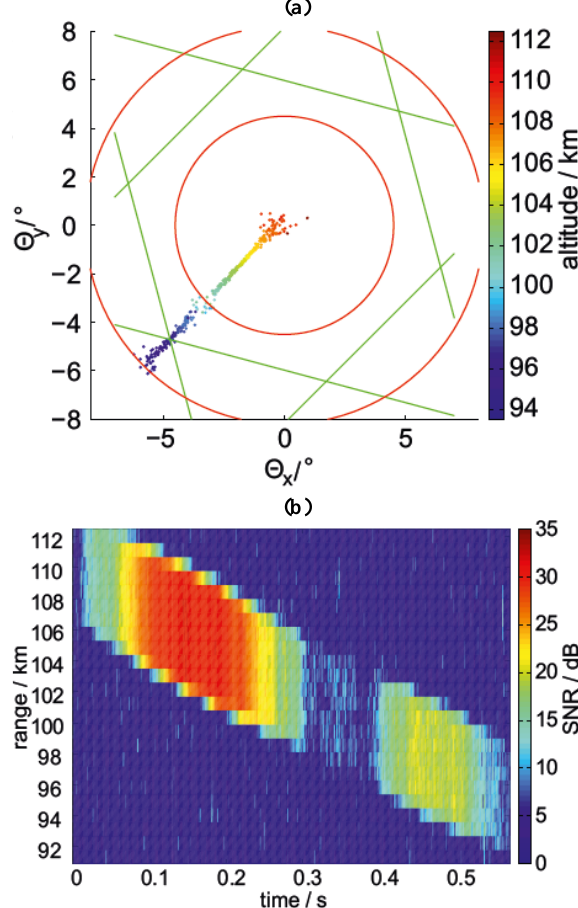
Fig. 12. (a) Projection of a meteor head echo in the 2-D plane after an interferometric analysis. (b) Range-time SNR plot of the same meteor head